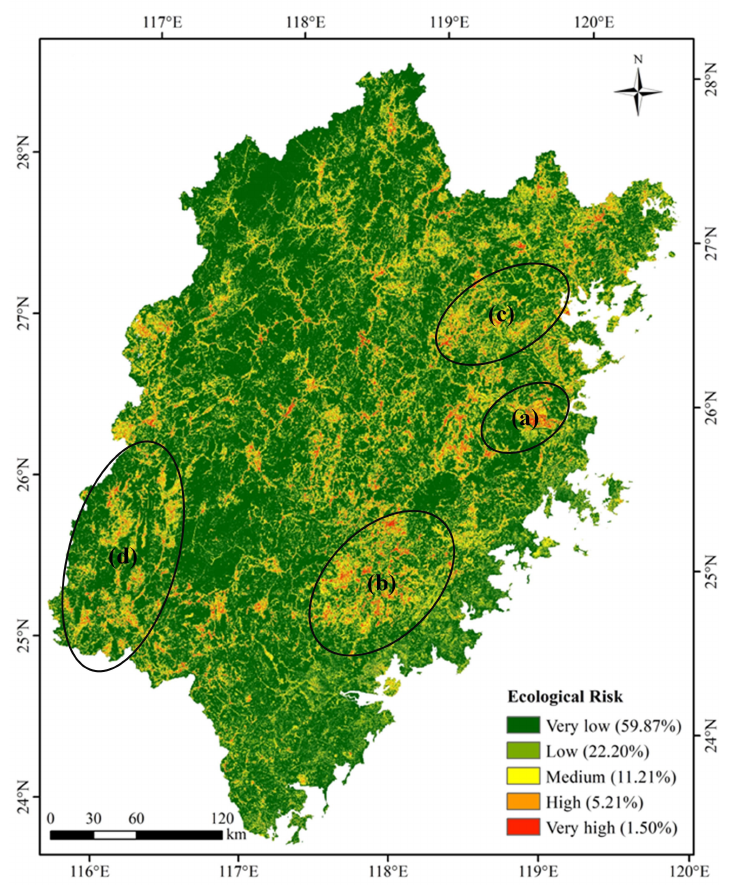
Figure 9. Spatial pattern of ecological risk. The circles are the typical regions with high ecological